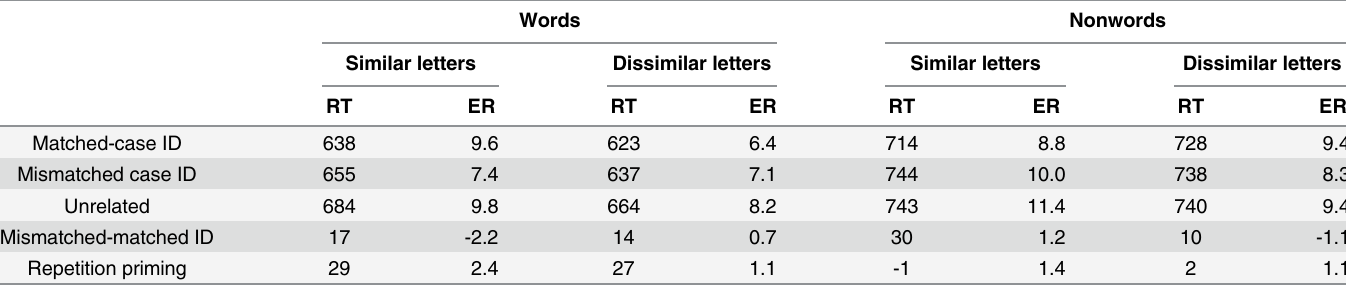
Table 1. Mean Lexical Decision Times (RTs, in Milliseconds) and Percentages of Errors (ERs) in each Condition for Word and Nonword Targets in the